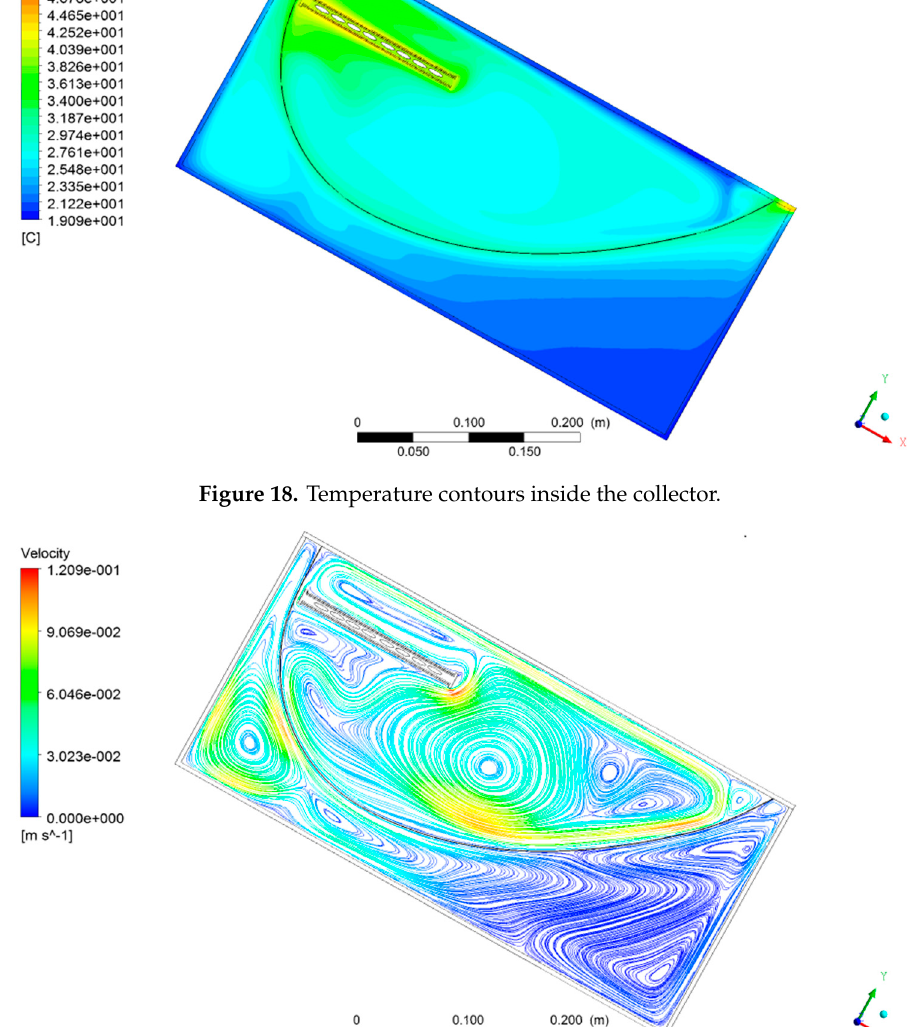
Figure 20. Thermal and electrical power of the collector for different tilt angles . 3.3.2. HTF Temperature Variation Different HTF temperatures were modeled and are presented in Figure 21. Figure 21 shows the performance of the collector versus Δ T (T m -T amb ). T m is mean HTF temperature and T amb is the ambient temperature. At higher HTF temperature, the thermal efficiency of the collector decreases and that is due to the decreasing temperature gradient between the receiver and HTF.